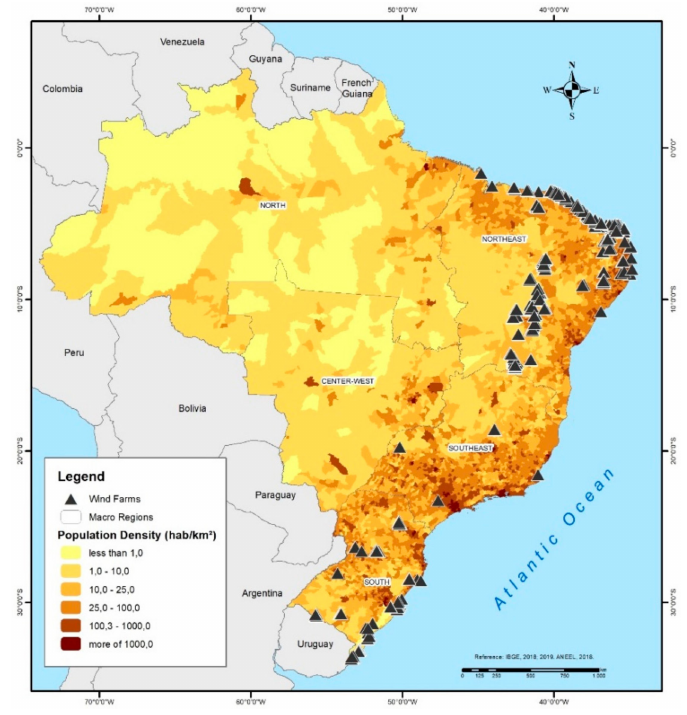
Figure 1. Wind farms in operation in Brazil. Source: